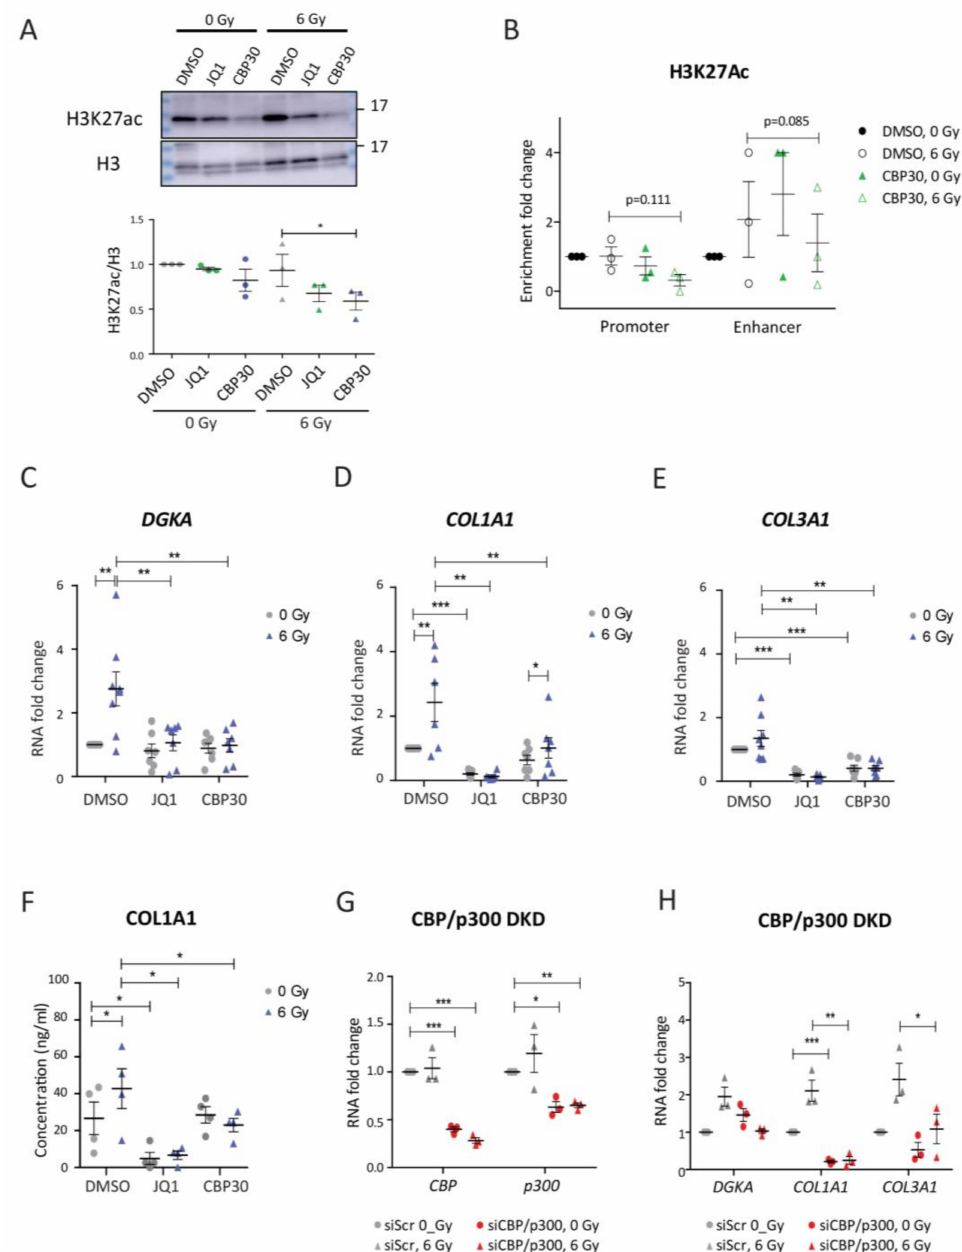
Figure 5. Bromodomain inhibitors reduce radiation-induced DGKA and pro-fibrotic marker expression in BJ cells. ( A ) Nuclear H3K27ac expression in BJ cells treated with bromodomain inhibitors. ( B ) Quantitative ACT-seq signals for H3K27ac enrichment at the DGKA locus in BJ cells. ( C – E ) Relative mRNA expression of DGKA ( C ), COL1A1 ( D ), and COL3A1 ( E ) in BJ cells. For ( A – E ), cells were pre-treated with DMSO, CBP (10 µ M), or JQ1 (5 µ M) for 48 h, irradiated with 6 Gy, and analyzed after an additional 48 h with concurrent drug treatment. ( F ) Secreted COL1A1 was measured by ELISA. Cells were pre-treated with DMSO, CBP (10 µ M), or JQ1 (5 µ M) for 48 h, irradiated with 6 Gy, and the conditioned medium was harvested after a further 72 h with concurrent drug treatment. ( G , H ) Relative mRNA expression of CBP and p300 ( G ) as well as DGKA , COL1A1, and COL3A1 ( H ) in BJ cells after silencing CBP and p300 . Cells were pre-treated with siRNAs directed against both enzymes for 48 h, irradiated with 6 Gy, and harvested after an additional 48 h. Statistical data are presented as mean ± SEM from three ( A , B , G , H ), six ( C – E ) or four ( F ) biological replicates. Statistical significance (* p < 0.05, ** p < 0.01, and *** p < 0.001) was determined by one-tailed Student’s t